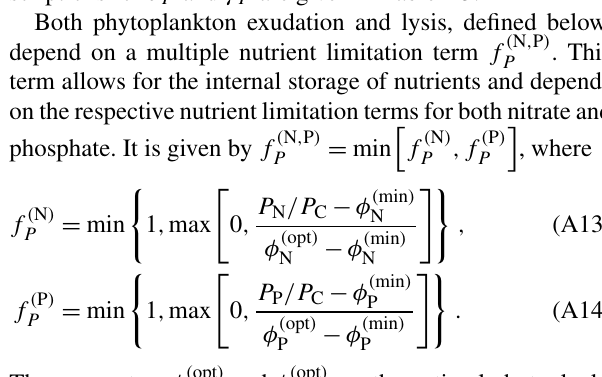
where b P is the basal specific respiration rate, γ P is the udation term is defined below in Eq. (A18). Values and de- scriptions for b P and γ P are given in Table